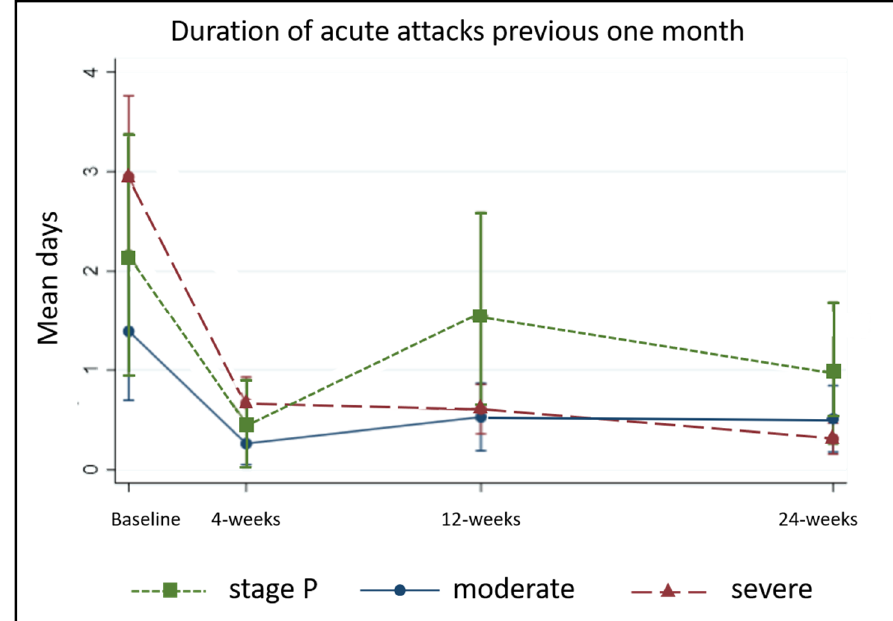
J. Clin. Med. 2020 , 9 , x FOR PEER REVIEW Figure 8. Duration of acute attacks by stage. Figure 8. Duration of acute attacks by stage.